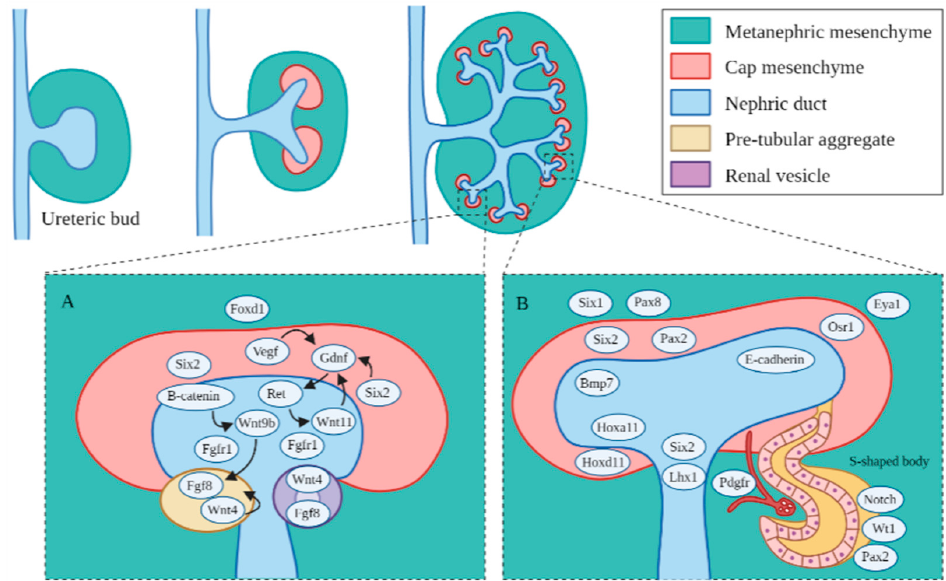
Figure 2. Major genes and signaling pathways in the formation of the ureteric bud branches, mesenchyme cap and subsequent nephrons. ( A ) Regulatory signaling pathways identified in the early metanephric mesenchyme. Foxd1 regulates specification of the metanephric mesenchyme to form the ureteric bud cap. Vegf , Six2 and Wnt11 are vital early progenitor factors that activate the Gdnf/Ret pathway for the proper branching of the ureteric bud and subsequent nephron formation. Fgf1 also contributes to proper ureteric bud branching in the ureteric bud. Fgf20 regulates Fgf1/2 in the formation of the ureteric cap. β -catenin mediated the induction of Wnt9 regulates Wnt4 and Fgf8 , which are critical for renal vesicle formation. ( B ) Key genetic markers identified in the metanephric mesenchyme and nascent nephrons. Hoxa11 and Hoxd11 regulate ureteric bud growth. Six1 and Six2 are important for continued mesenchyme differentiation. Pax2 and Pax8 are important for continued nephric duct formation. E-cadherin and the other cadherins indicate the segmentation of the S-shaped body, and E-cadherin is expressed in the distal segments where the S-shaped body joins the ureteric bud. Pdfgr plays a role in the formation of the glomerulus.